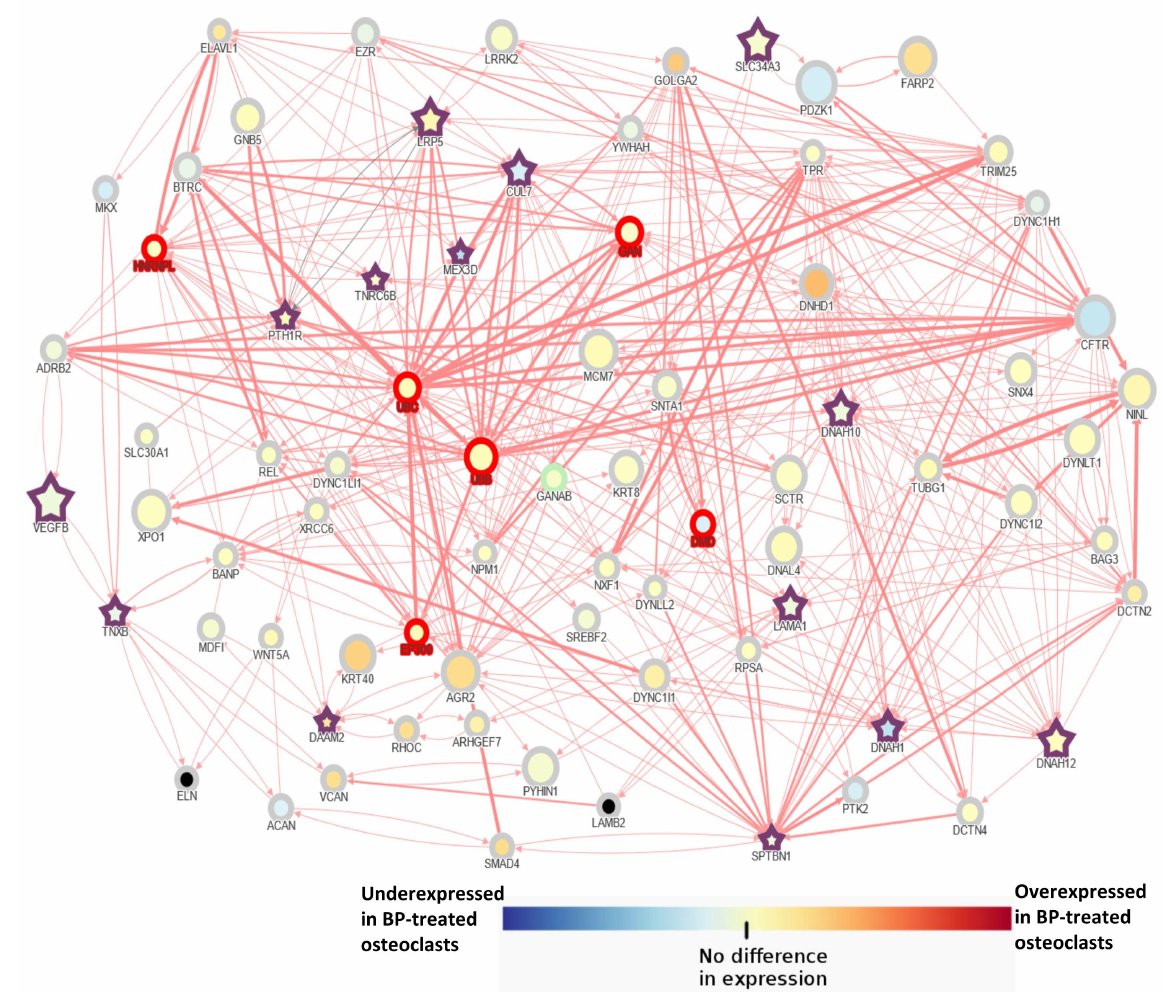
Figure 3. Network analysis of bone-related genes mutated in at least 2 AFF patients using the AFFNET tool. The shortest path interactions among candidate genes were displayed. Purple stars indicate candidate genes. The size of the nodes is determined by observed/expected loss of function score in the gnomAD database. This score is the ratio of the observed and expected loss of function variants in a particular gene. This score provides insight into how tolerant a gene is to loss of function variation. The red border tags genes that are outlier in the constrain metrics for LoF or missense variants according to gnomAD. Node color represents their expression depending on the expression data obtained in the GSE63009: Osteoclastic precursor cells treated or not with bisphosphonates (alendronate or risedronate) during their differentiation into mature